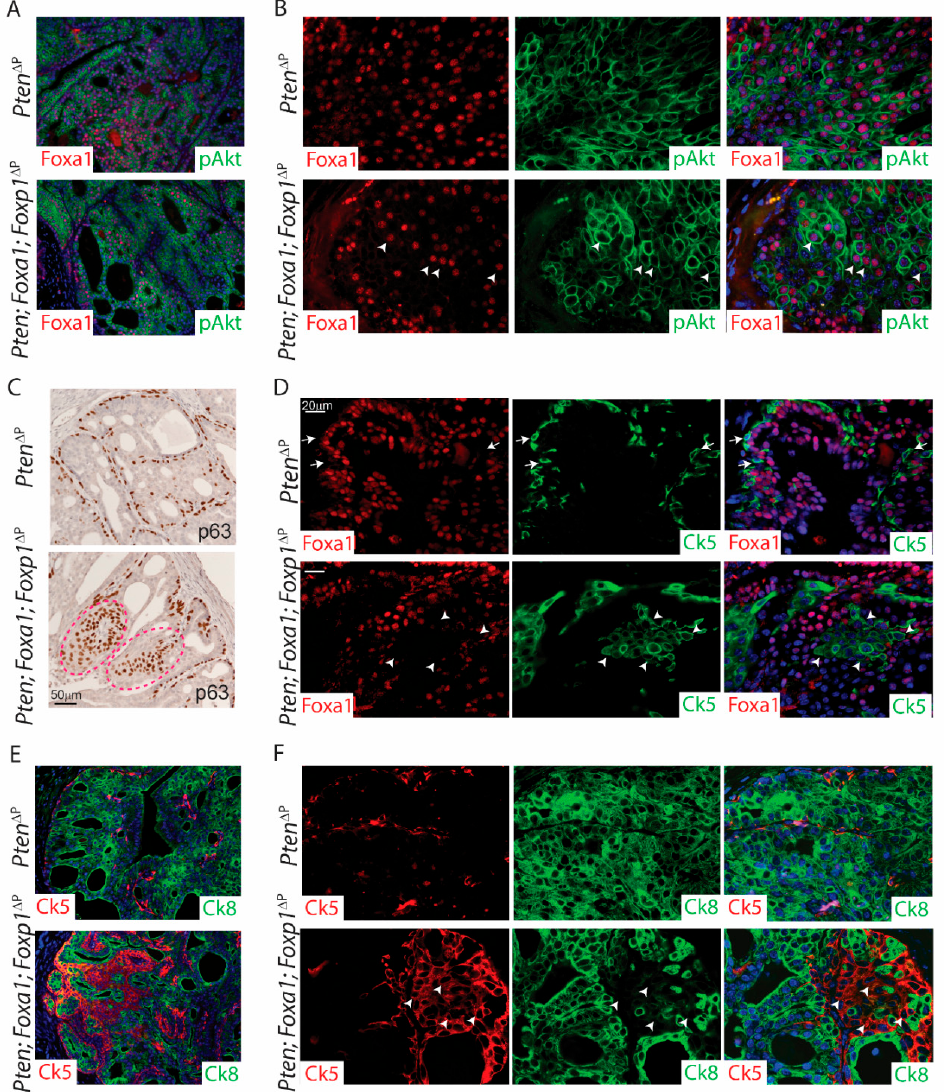
Figure 5. Loss of Foxa1 drives prostatic cell-plasticity. Paraffin sections from Pten Δ P and Pten; Foxa1; Foxp1 Δ P prostates were stained with antibodies. ( A , B ) Immunofluorescence staining for p-Akt (green) and Foxa1 (red). White arrowheads mark Foxa1 and pAkt double positive cells ( n = 3). ( C ) IHC staining for basal cell marker p63. Red dotted line marks abnormal areas positive for basal cells in the prostatic lumen ( n = 5). ( D ) Immunofluorescence staining for Ck5 (basal marker; green) and Foxa1 (red). White arrows mark basal cells towards the stroma in Pten-deficient samples. White arrowheads marks Ck5-positive and Foxa1-negative cells in the lumen of Pten; Foxa1; Foxp1-defi- cient anterior prostate lobes ( n = 3). ( E , F ) Immunofluorescence staining for Ck5 (basal marker; red) and Ck8 (luminal marker; green). White arrowheads mark Ck5-positive and Ck8-negative cells in the prostatic lumen ( n = 3). Panels on the left are taken with 10× magnification and panels on the right are taken with 40x magnification.